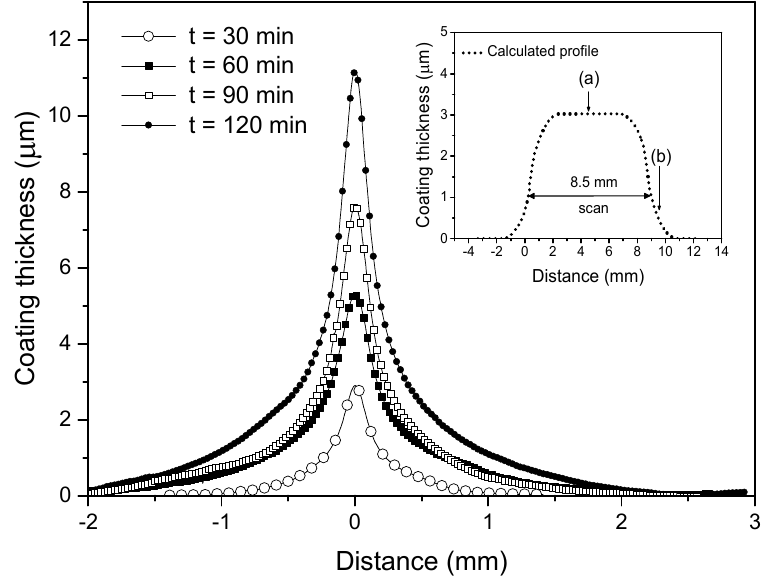
Figure 3. Representative time dependent DLC deposition profiles produced with a stationary ion source. The inset represents the calculated profile of a DLC deposition with a moving ion source. Plateau (a) and run off regions (b) are